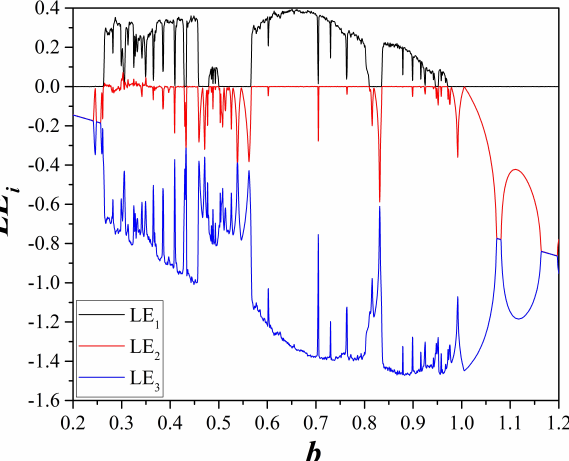
Figure 4. Spectrum of Lyapunov exponents of system (2), when varying b , for a = 4 × 10 − 4 , c = 3.846 × 10 − 4 and d = e = 1.